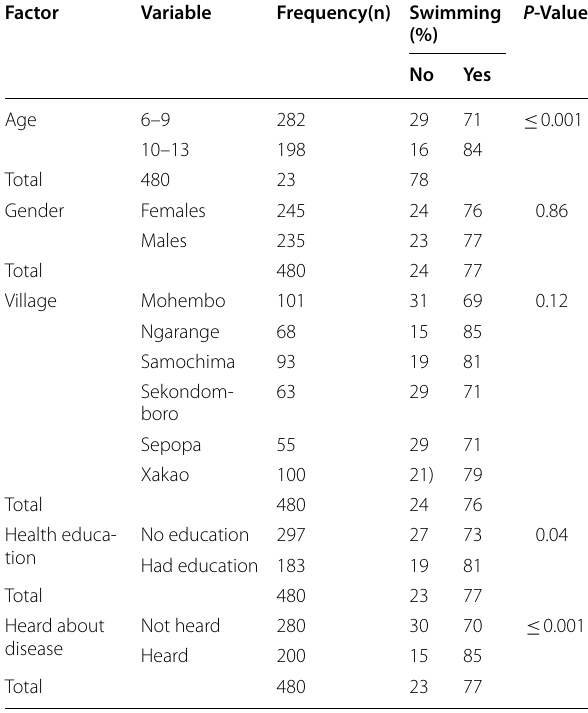
Table 5 Knowledge of swimming as a risk behaviour